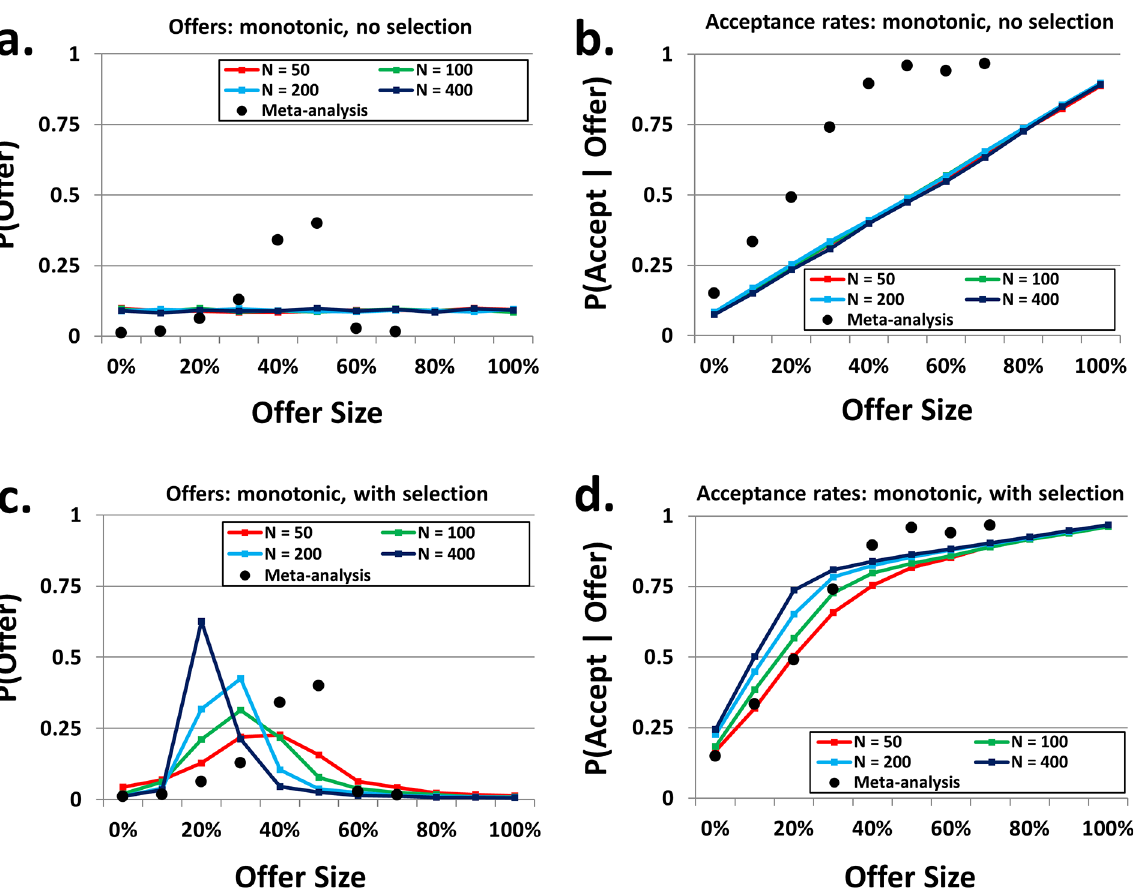
Fig 2. Final genotypes for monotonic acceptance rates. The lines in each panel show the mean genotype for each population size across the eleven possible offers. For each panel, black dots denote offer frequencies and conditional acceptance rates of human subjects, according to a meta-analysis of multiple behavioral studies. Because offers greater than 65% are rare in human studies, the rightmost dot comprises all offers of 65% or greater. (a) Frequencies of proposed offers without selection pressure. When the identities of reproducing agents were determined randomly, offer sizes were all equally frequent. (b) Rates of acceptance, conditional upon offer size, without selection pressure. When the identities of reproducing agents were determined randomly, but acceptance rates were constrained to be monotonically increasing, acceptance rates became linear with respect to offer size. (c) Frequencies of proposed offers with selection pressure. In contrast to the non-monotonic simulations, behavior shifts toward fairer offers, with modal offer sizes of 30%- 40%. As in the non-monotonic simulations, larger populations tended toward lower offers than smaller populations. (d) Rates of acceptance, conditional upon offer size, with selection pressure. When the probability of reproduction was proportional to earnings, acceptance rates became non-linear with offer size, with concavity increasing with population